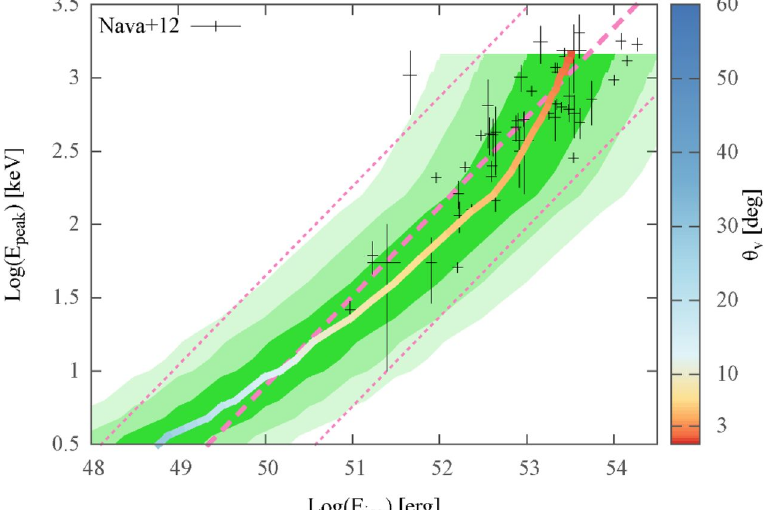
Figure 7. Rest frame peak energy E peak versus isotropic equivalent energy E iso of long GRBs. The data points (cross symbols) are a flux-limited sample of bright Swift bursts. The dashed (dotted) line shows the correlation regression line (and its 3 σ scatter). The color-coded solid line shows the values of E peak and E iso assuming a structured Gaussian jet seen under progressively larger viewing angles-vertical color-code bar). The green shadows, representing the 1, 2, 3 σ confidence levels around the color-coded line, are obtained considering a dispersion of the core energy of 0.5 dex around a nominal value of 3 × 10 53 erg. Figure reproduced from